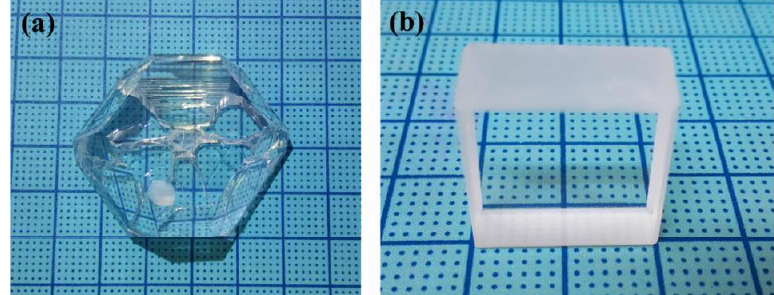
Figure 20. ( a ) The as-grown Zn 4 B 6 O 13 single crystal with a dimension of 40 mm × 40 mm × 18 mm; ( b ) Fabricated single crystal with a dimension of 20 mm × 20 mm × 10mm. Reprinted from Ref. [67], with permission of John Wiley and Sons.